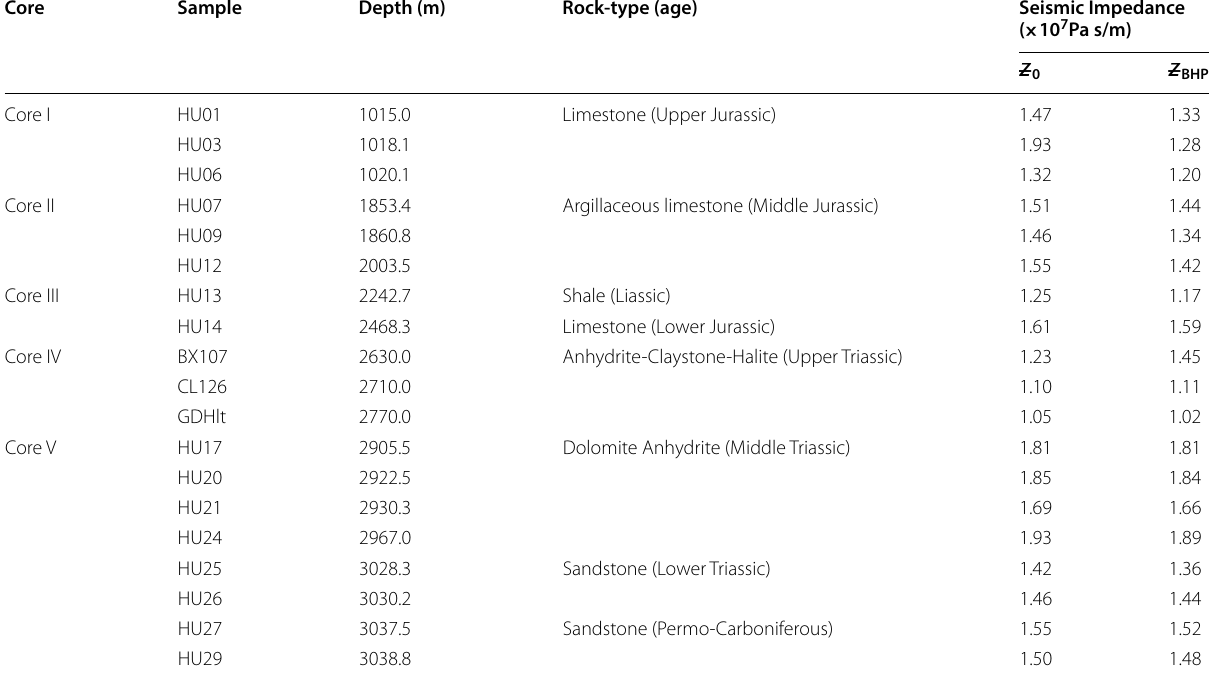
Seismic Impedance is calculated as a function of intrinsic seismic velocities, − Z 0 , as well as at the Bottomhole Pressure, − Z BHP . The in-situ seismic velocity was derived following Wepfer and Christensen (1991) relationship (Eq. 7) in text and using the parameters A , B , a , and b provided in Table 4)